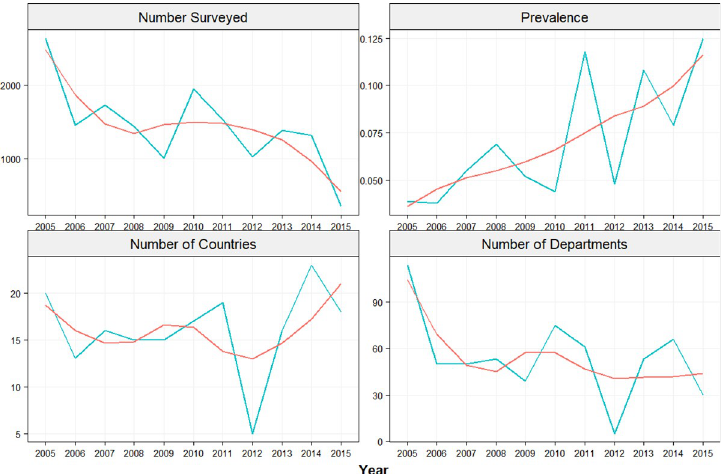
Fig 5. Annual number of patients screened, HAUTI prevalence, number of departments participating and number of countries in the GPIU study carried out in Europe.